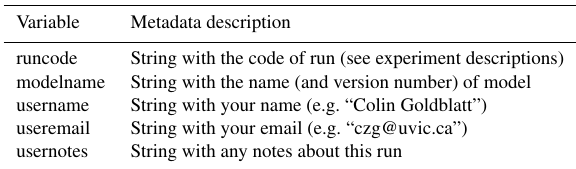
Table 3. Model metadata to be included with PALAEOTRIP sub- missions.